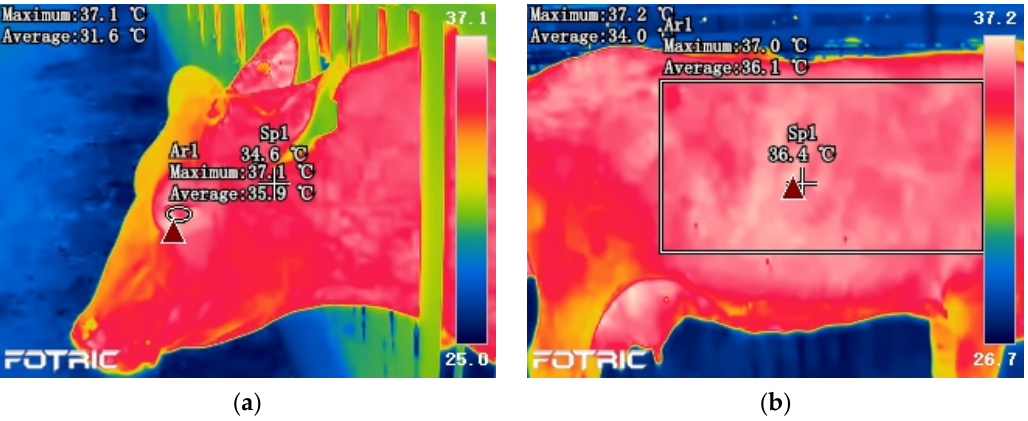
Figure 2. Illustration of the eye temperature ( a ) and skin temperature ( b ) measurements.